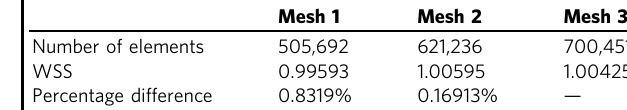
Table 3 Details of the mesh dependency